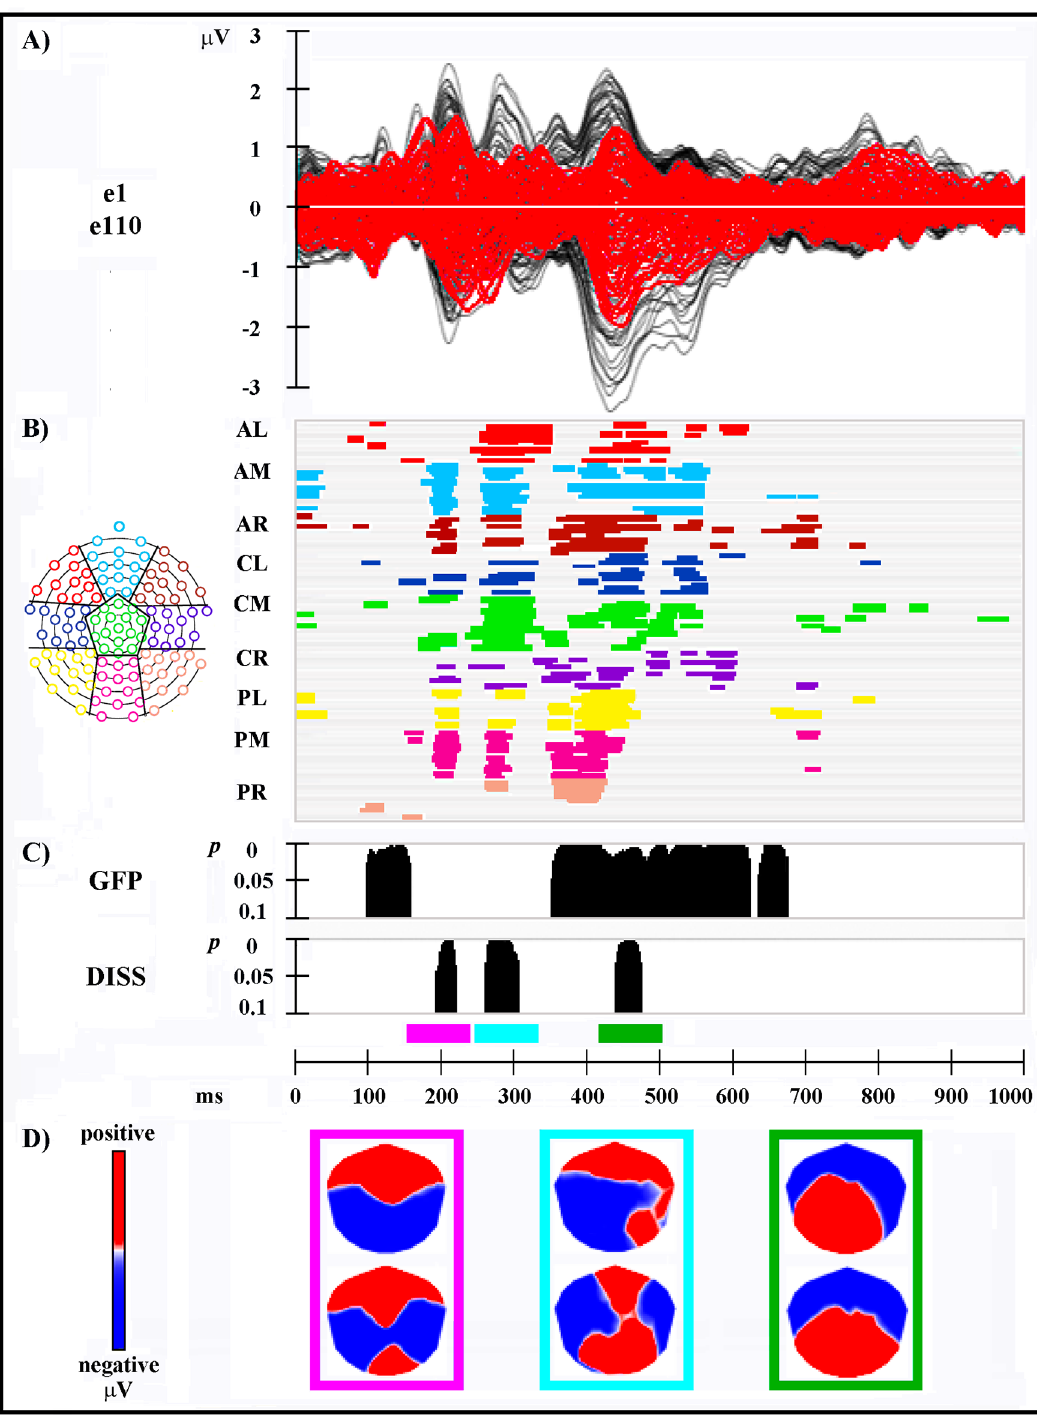
Fig 2. Electrophysiological results over 1000 ms after cue onset (cue onset: 0 ms). (A) Group-averaged (n = 15) event related potential (ERP) waveforms of the two experimental sessions, superimposed across the 110 recording channels (e1 – e110). Black: session A cue; red: session B cue. (B) Statistical analysis of global ERP amplitude. Periods of significant differences of ERP amplitude ( p < .05; duration (cid:1) 20 ms) at each electrode and time point between sessions are displayed as colored horizontal lines. Each horizontal line represents one scalp electrode. Different colors indicate different clusters of electrodes; the distribution of the clusters over the electrode montage is shown in the inset on the left side of the figure. AL: anterior left; AM: anterior midline; AR: anterior right. CL: central left; CM: central midline; CR: central right. PL: posterior left; PM: posterior midline; PR: posterior right. (C) Global scalp electric